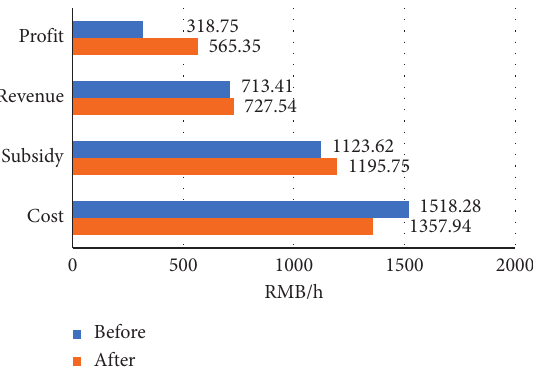
Figure 5: Lower-level transit profit structure before and after the adjustment with the proposed model.